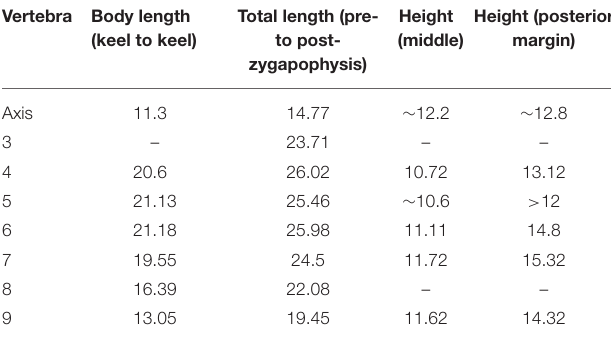
TABLE 3 | Measurements (in mm) of the anterior presacral vertebrae of PIMUZ T 1559. Vertebra Body length (keel to keel)